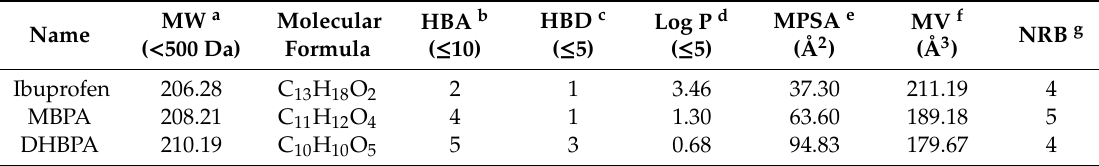
Table 3. Oral bioavailability properties of ibuprofen and benzoylpropionic acid derivatives.